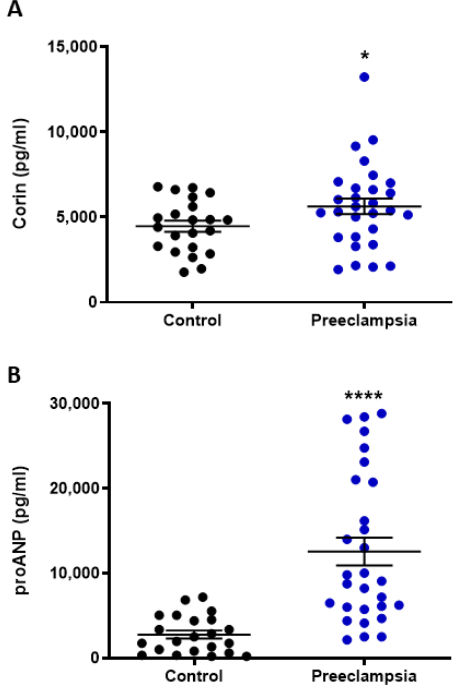
Figure 1. Circulating levels of corin and NT-proANP increased with preeclampsia. In pregnancies complicated by preterm preeclampsia (delivery <34 weeks gestation), there was a significant increase in plasma concentrations of corin ( A ) and N-terminal (NT)-proANP ( B ) compared to gestation-matched (normotensive) controls. Data are mean ± SEM, n = 22–29, * p < 0.05, **** p < 0.0001. Within the placenta, the mRNA expression of corin and the ANP-encoding gene, Int. J. Mol. Sci. 2023 , 24 , x FOR PEER REVIEW natriuretic peptide precursor A ( NPPA ), did not significantly differ between pregnancies complicated by preterm preeclampsia or gestation-matched normotensive controls (Figure 2A,B).